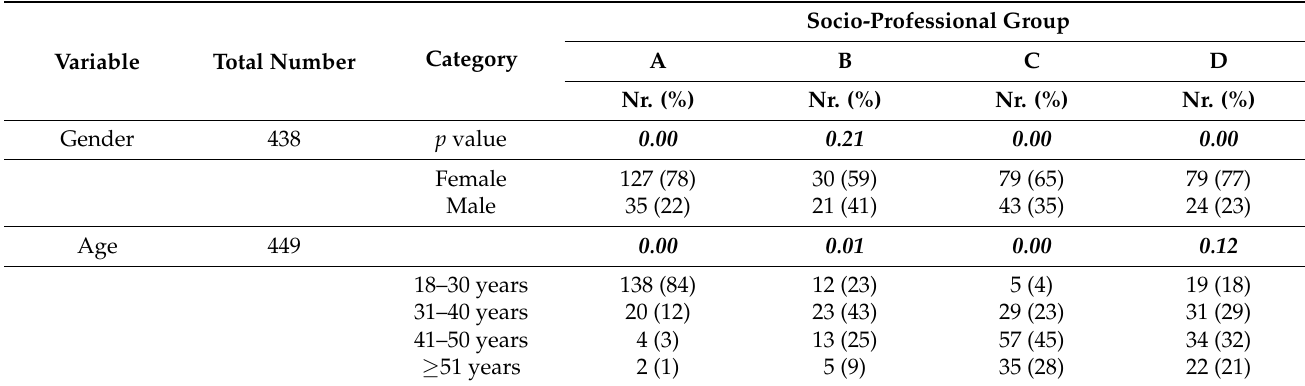
Table 2. Proportions of gender and age by the socio-professional group responses.